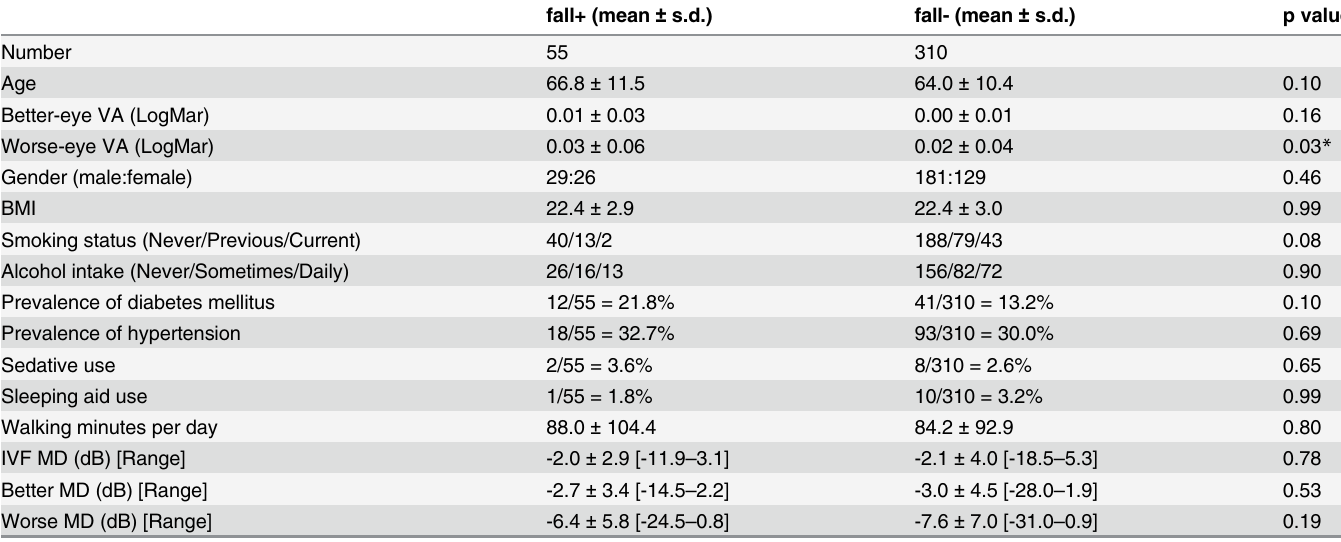
Table 1. Comparison of variables between patients with and without a history of falls. fall+ (mean ± s.d.) fall- (mean ± s.d.) p